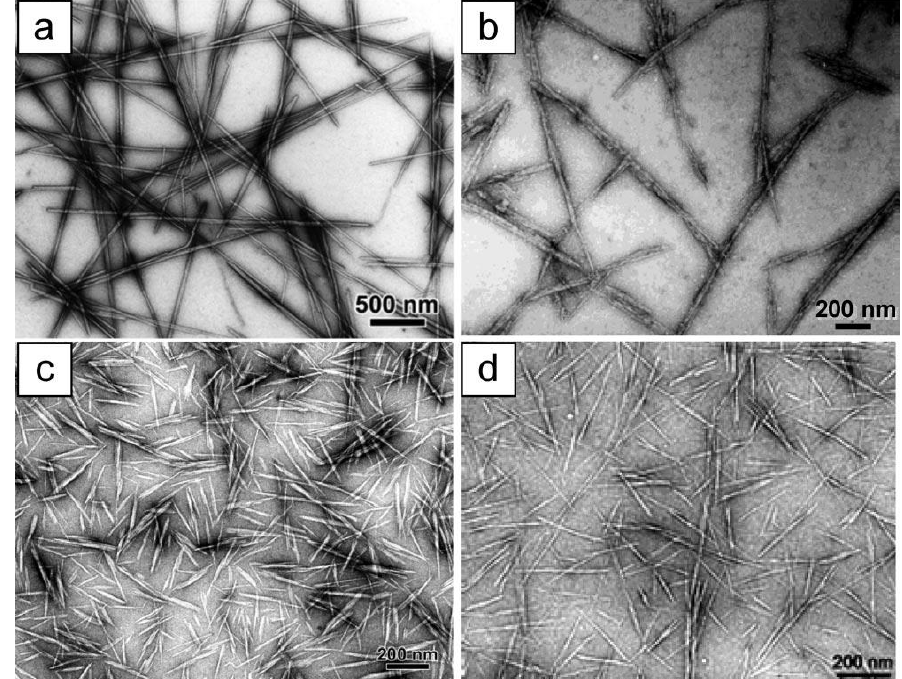
Figure 15. TEM images of dried dispersion of cellulose nanocrystals derived from ( a ) tunicate; ( b ) bacterial; ( c ) ramie; ( d ) sisal. Reprinted with permission from [69]. Copyright 2010 American Chemical